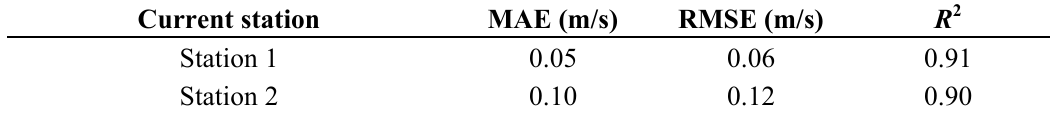
Table 2. Statistical error of the difference between the computed and observed tidal